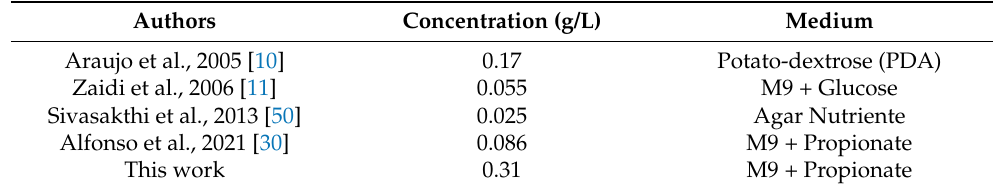
Table 3. Comparative table of IAA production by Bacillus subtilis in different culture media.